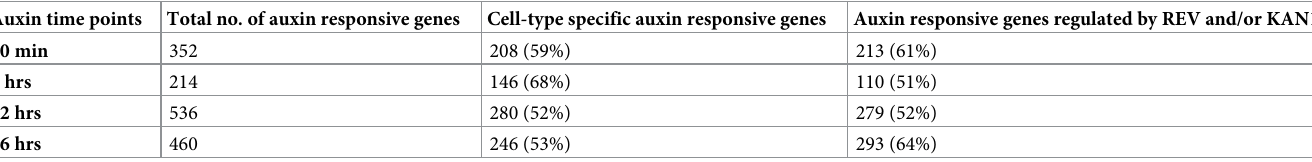
Table 4. Regulation and expression pattern of auxin responsive